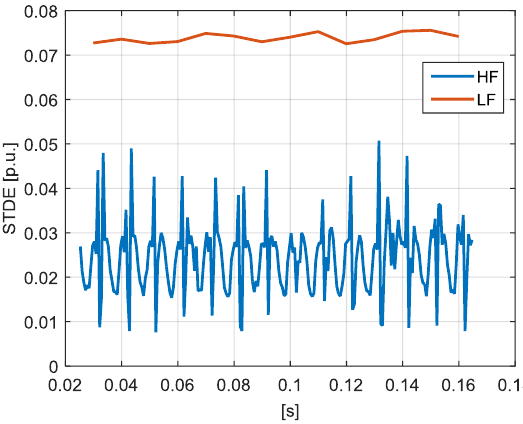
Figure 12. Case study 2: STDE at low-frequency (0 ÷ 2 kHz, red line) and at high-frequency (2 ÷ 150 kHz, blue line) obtained by the instantaneous approach.